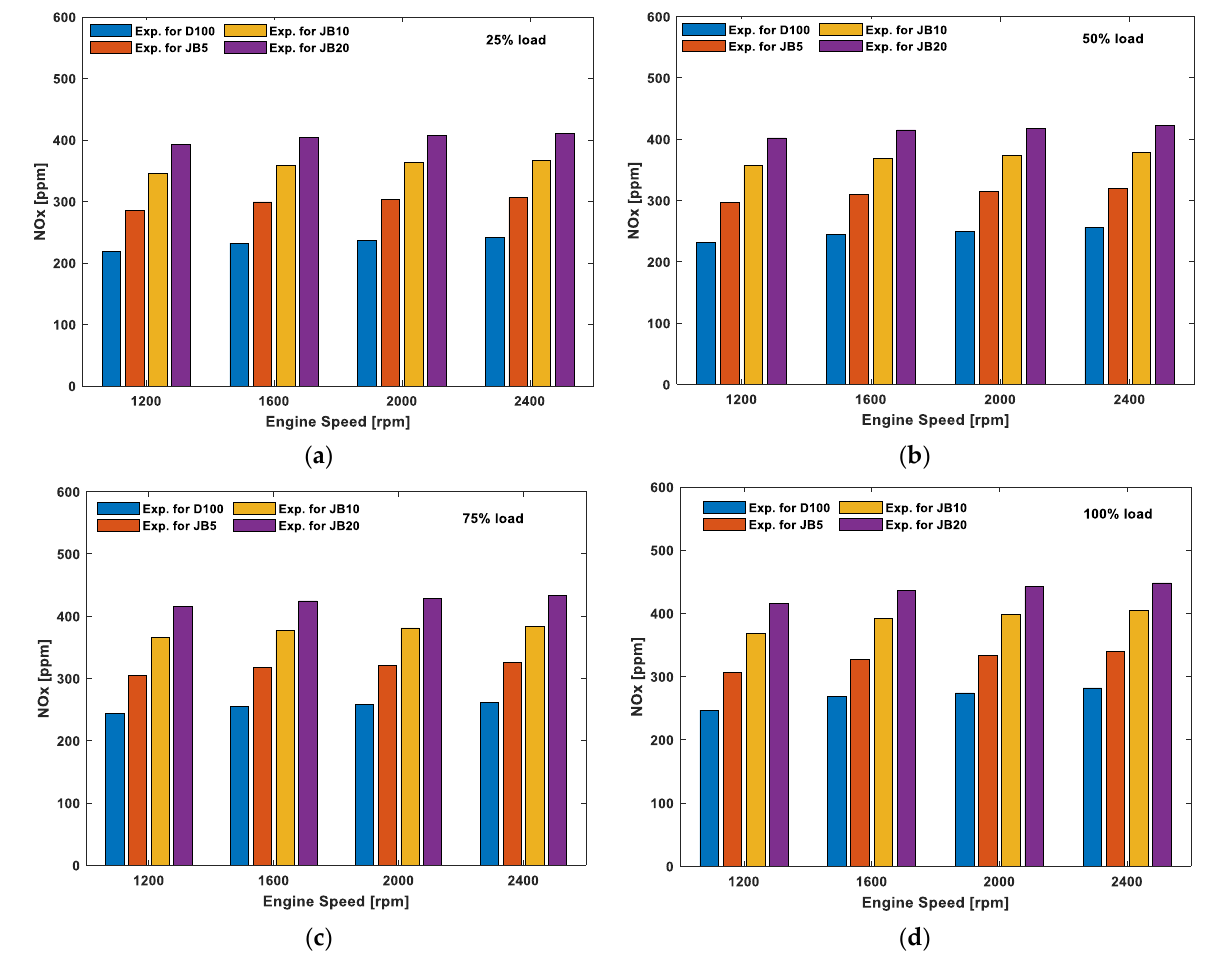
Figure 8. Variation in NO x with engine speeds for D100, JB5, JB10, and JB20 at ( a ) 25%, ( b ) 50%, ( c ) 75%, and ( d ) 100% loading operation .